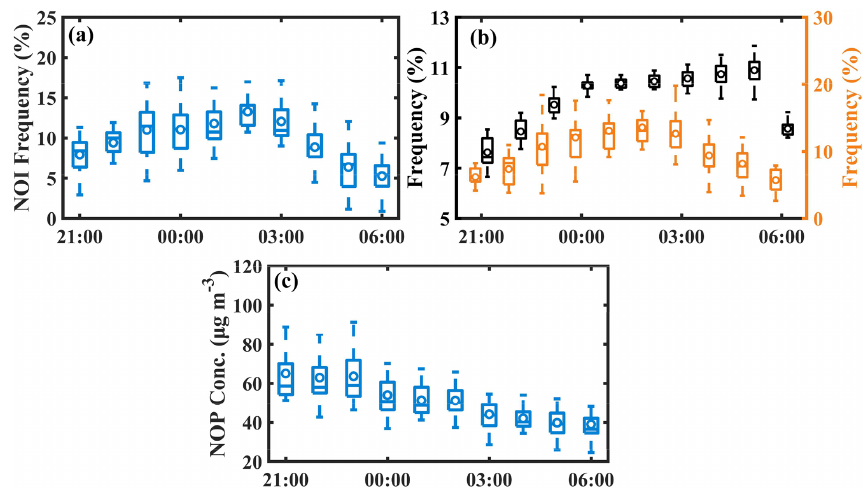
Figure 6. Diurnal variation of (a) the frequency of NOI events, (b) the frequency of total LLJs (black) and the LLJs that can induce NOI events (orange), and (c) NOP concentrations during 21:00–06:00 (LTC) in the PRD region during 2006–2019. The error bars indicate the range of deviations for the 16 air quality sites.